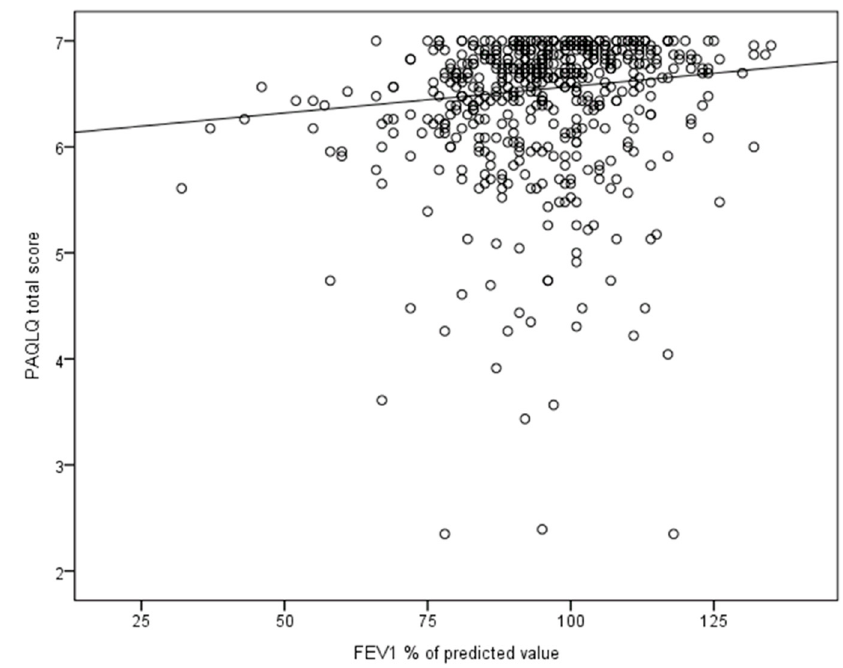
Table 5. Results of longitudinal associations between the PAQLQ scores and FEV 1 percentage of the predicted value, β 2 -agonist use, dose of fluticasone or equivalent, age, sex, trial site, season, wheezing episodes in the preceding year, PC 20 histamine test, atopy, FeNO, exacerbations in the previous 2 months, and exposure to second-hand smoke. Only data of significant predictors are shown and asthma control was excluded from the analysis. PAQLQ totalscore PAQLQ symptomsdomain PAQLQ activitylimitationsdomain β CI P value β CI P value β CI P value FEV 1 per 10% predicted value * 0.05 0.01, 0.08 < 0.01 0.04 FEV 1 : forced expiratory volume in 1 second, β 2 -agonist = use of rescue medication, PAQLQ = Pediatric Asthma Figure 3. Associations between β 2 -agonist use and the PAQLQ total score in a linear mixed Control Quality of Life Questionnaire, β = estimate of corresponding factor in the model, CI = 95% confidence model ― all measurements taken during one year are included † . * Use of rescue medication during interval of the estimate. Adjusted for: seasons, trial site (Maastricht or Sittard), sex, age, PC 20 histamine test, atopy, the week preceding the clinical visit: 0 = 0 puffs most days, 1 = 1 – 2 puffs most days, 2 = 3 – 4 puffs exposure to second-hand smoke, FeNO, and daily dose of fluticasone or equivalent. * Increase in the PAQLQ score / 10% increase of the FEV 1 percentage of the predicted value. † Decrease in the PAQLQ score / increase in the most days, 3 = 5 – 8 puffs most days, 4 = 9 – 12 puffs most days, 5 = 13 – 16 puffs most days, and 6=more ACQ score concerning a β 2 -agonist use. ‡ Decrease in the PAQLQ score in the case of the occurrence of exacerbations than 16 puffs most days. The regression line is based on the model in which the asthma control in the preceding 2 months. § Increase in the PAQLQ score in the case of increasing wheezing episodes during the year preceding the study. Model with the PAQLQ emotional functioning domain as the dependent variable: no levels were excluded, the estimates of this model are given in Table 4. For factors in the equation factor was associated with the PAQLQ emotion functioning domain (see text). other than the use of rescue medication, mean values were used.